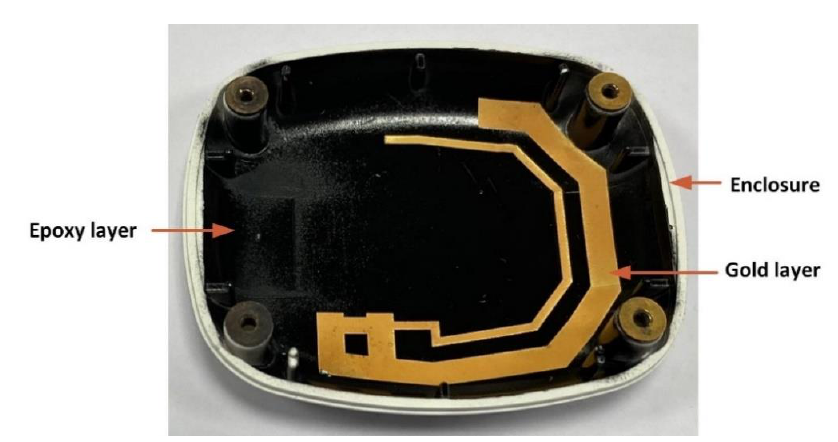
Figure 12. LPKF laser direct structuring (LDS) printed